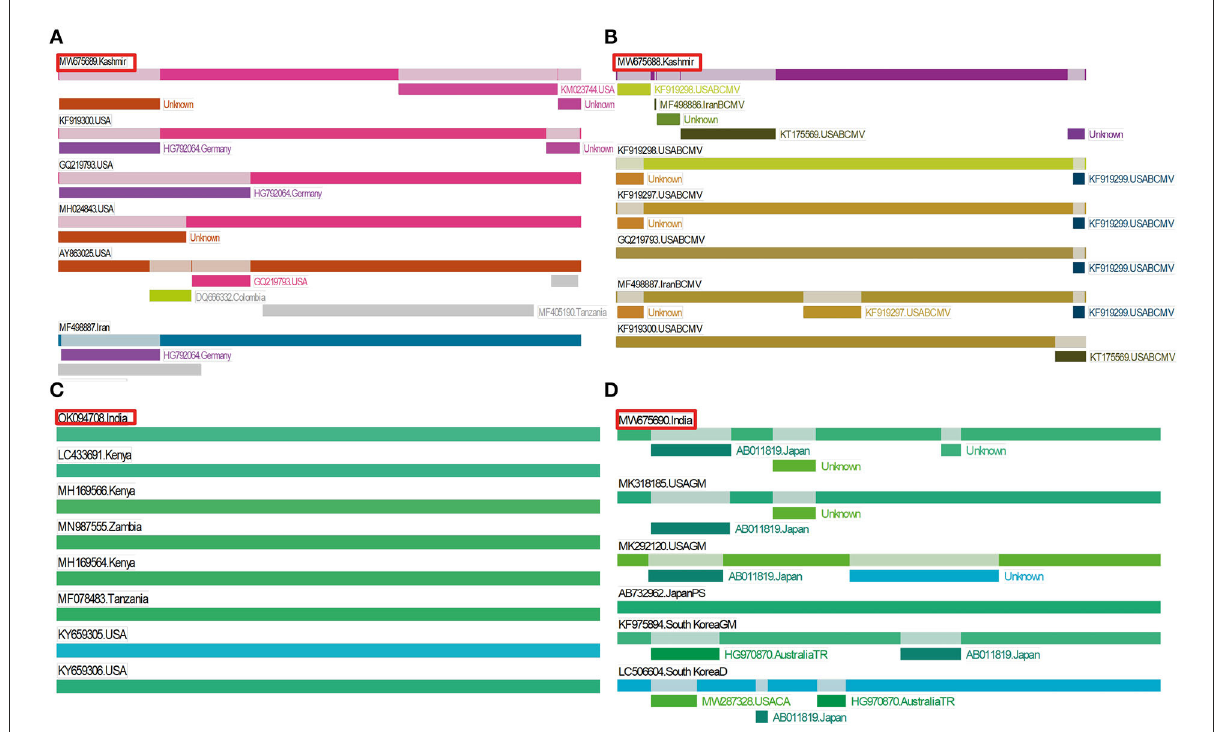
FIGURE6 Recombination events detected in identified viruses by using RDP. Position of our isolate is highlighted in red color. (A) Three recombination events detected in BCMV 1, (B) four recombination events detected in BCMV 2, (C) recombination was not found in BCMNV, and (D) two recombination events detected in